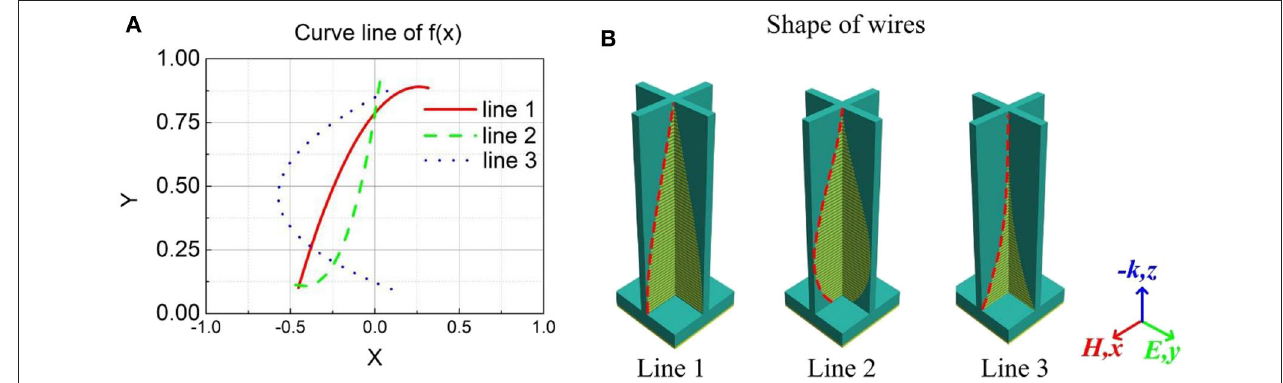
FIGURE 3 | Curve and shape of strips. (A) Different curves generated by function f(x) and (B) the corresponding structure of SSPPs.